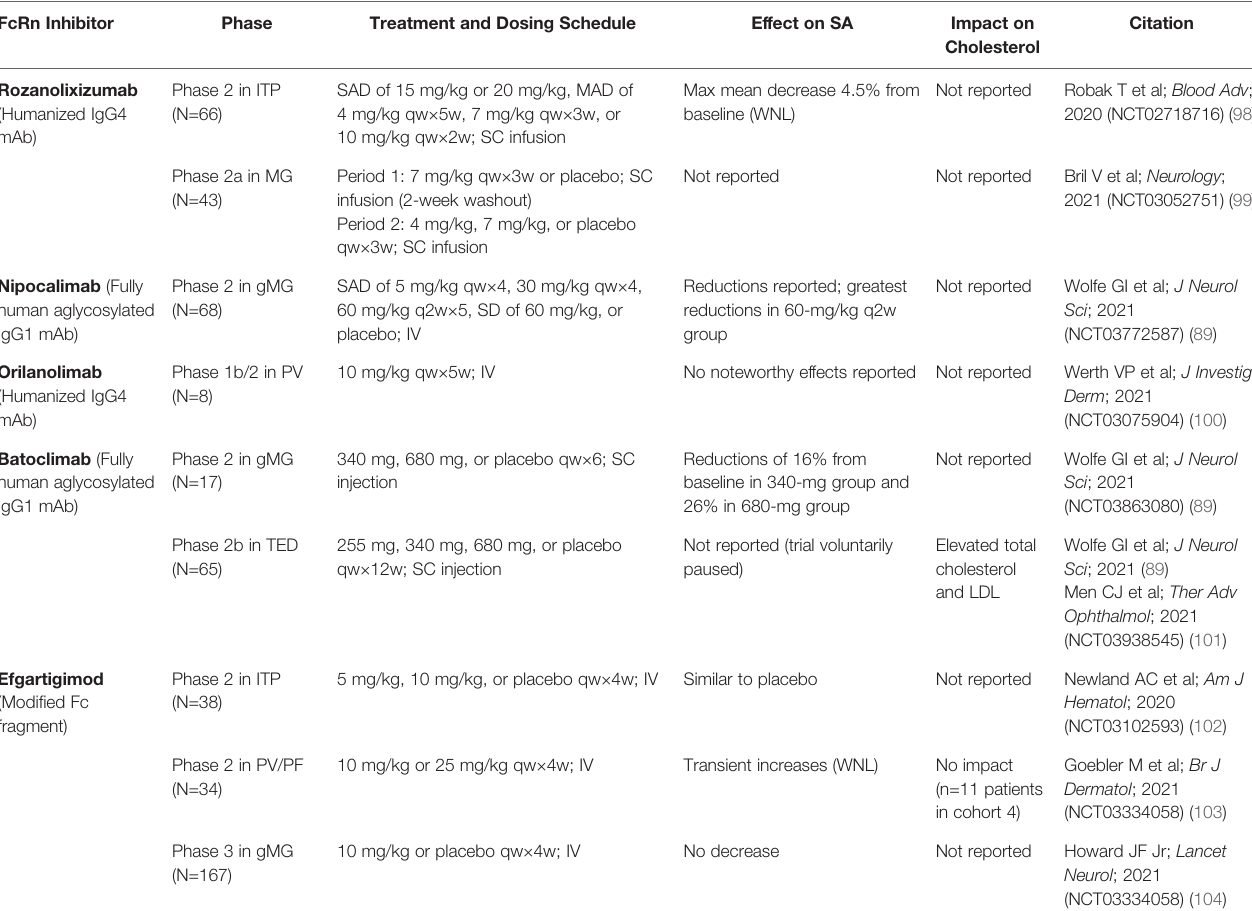
TABLE 3 | Effect of FcRn inhibitors on serum albumin concentration and cholesterol in phase 2 and phase 3 studies. FcRn Inhibitor